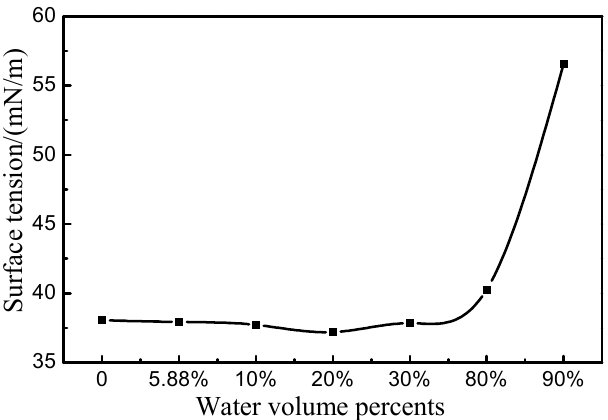
Figure 6. Surface tension of homogeneous [bmim]Fe(III)Cl 4 –H 2 O mixtures at different x (H 2 O) at 25 °C.